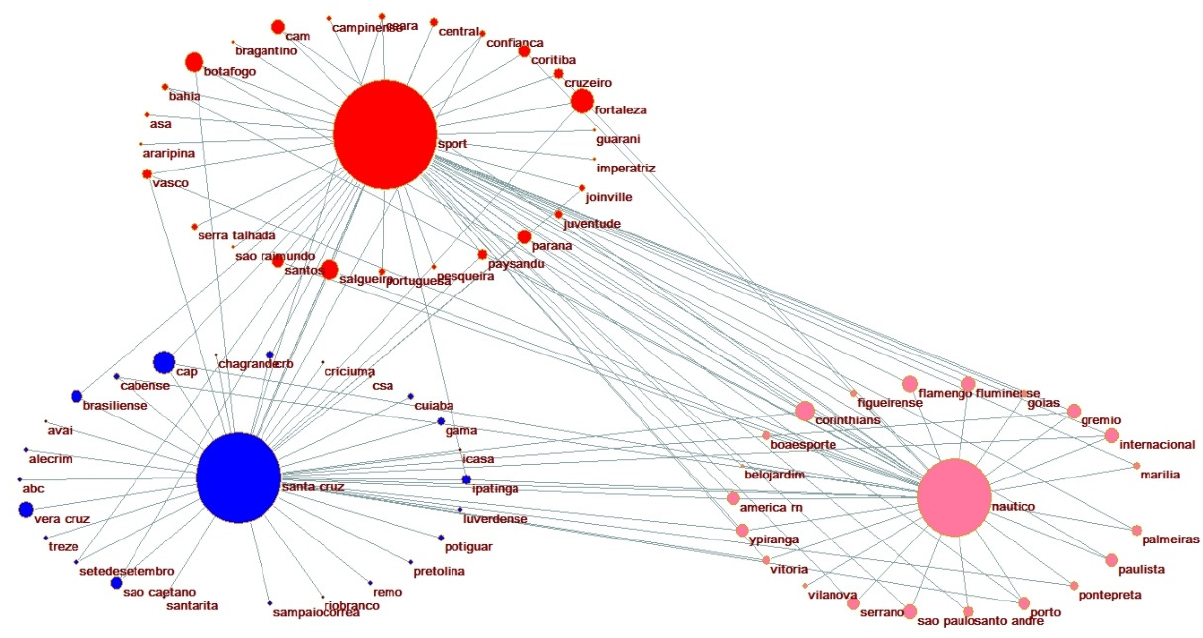
Figure 3. Hooligan network clusters by clubs.